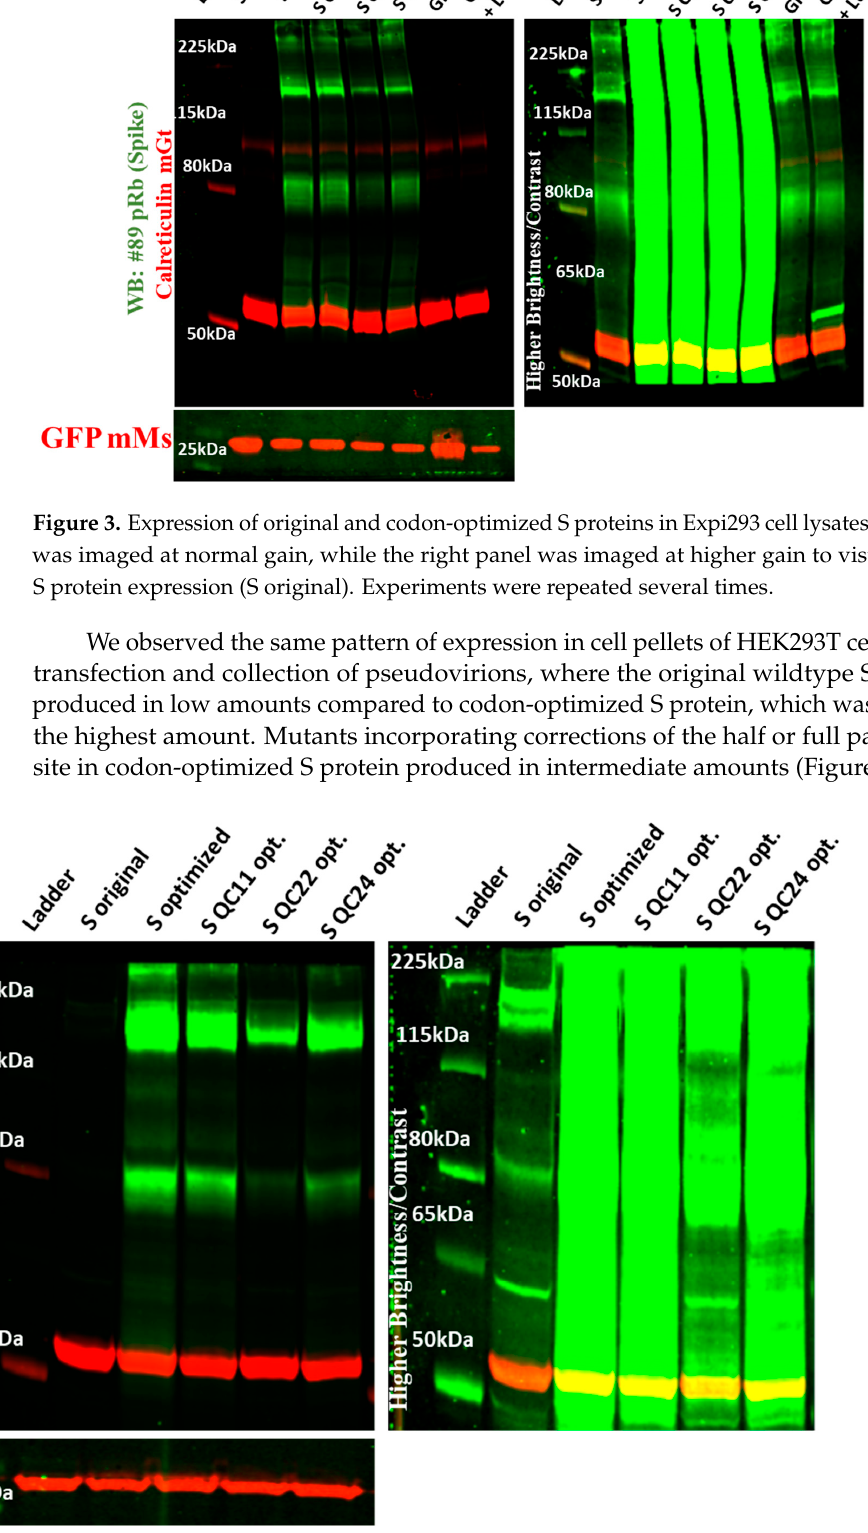
Figure 4. Expression of original and codon-optimized S proteins in HEK293T cell lysates. The left panel was imaged at normal gain, while the right panel was imaged at higher gain to visualize original S protein expression (S original). Experiments were repeated several times.